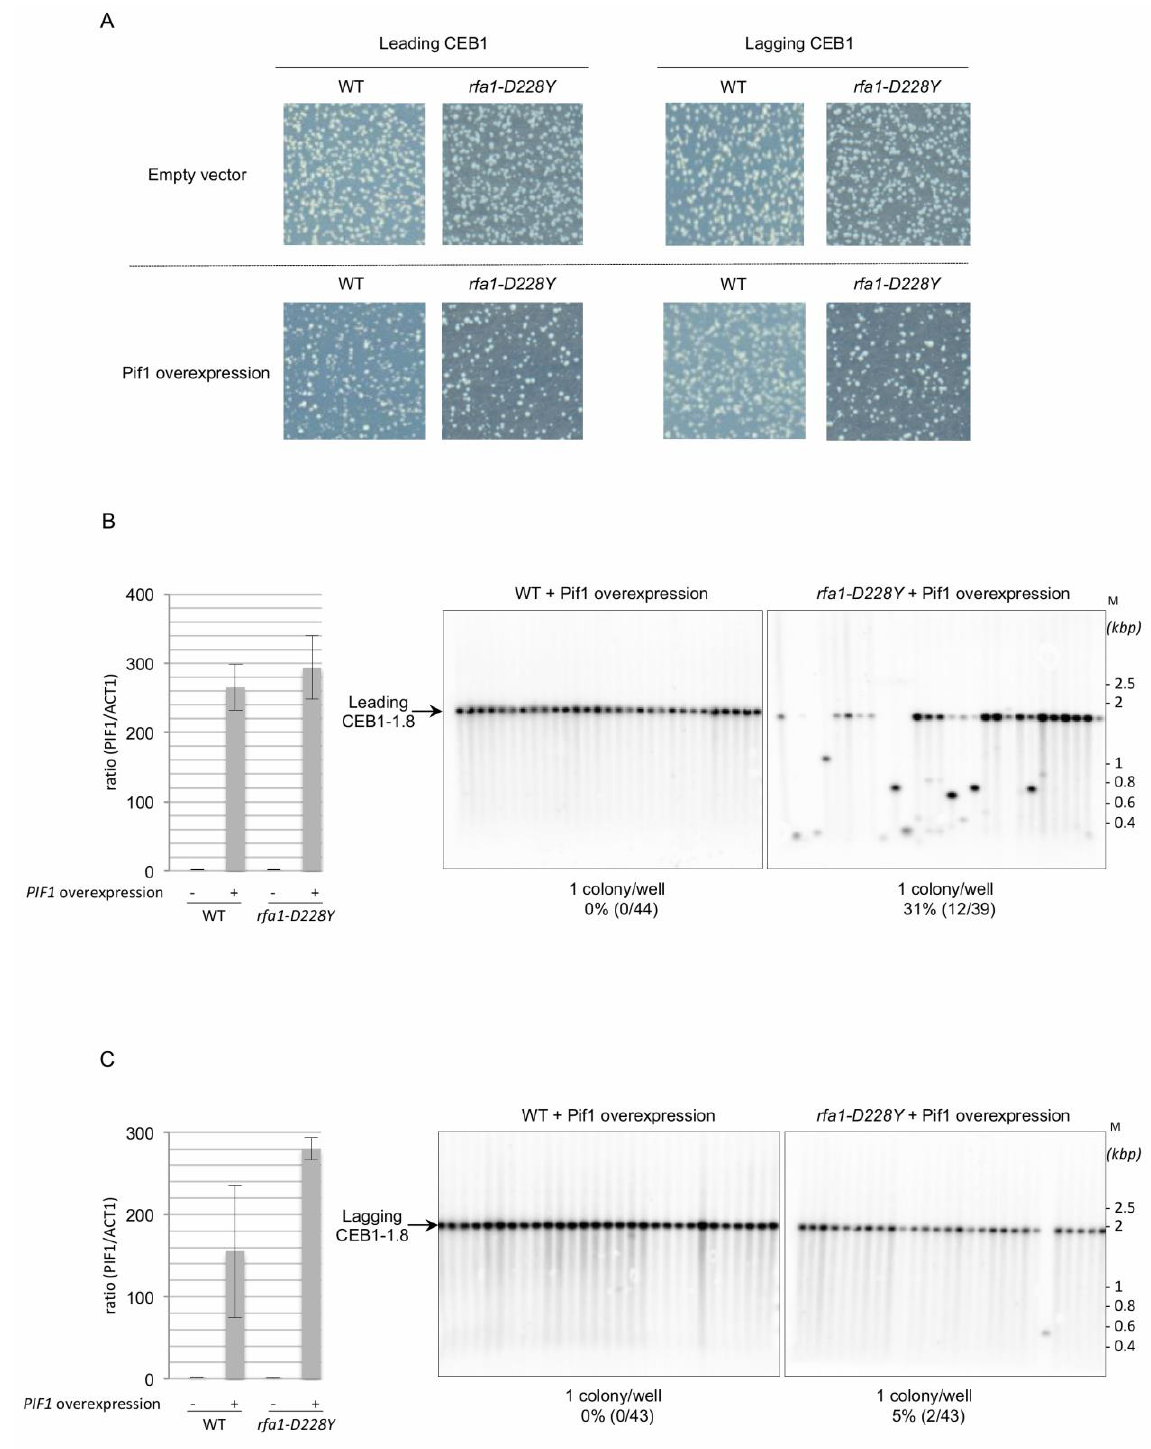
FIGURE 3: Pif1 overexpression rescues lagging-CEB1 instability in the rfa1-D228Y mutant. (A) Colonies containing the leading- or lagging-CEB1, and overexpressing Pif1 (Pif1 overexpression) or not (Empty vector) were plated on galactose medium and subsequently incubated at 30°C. (B) Left: cDNA was prepared from the indicated strains. The ration of PIF1 transcript to that of ACT1 was determined using qPCR. (-): Empty vector, (+): Pif1 overexpres- sion. Right, genomic DNAs from wild-type (WT) or rfa1-D228Y cells overexpressing Pif1 (Pif1 overexpression) and containing the leading-CEB1 were treated as in Figure 2. M: ladder DNA. (C) Left: cDNA was prepared from the indicated strains. The ration of PIF1 transcript to that of ACT1 was deter- mined using qPCR. (-): Empty vector, (+): Pif1 overexpression. Right, genomic DNAs from wild-type (WT) or rfa1-D228Y cells overexpressing Pif1 (Pif1 overexpression) and containing the lagging-CEB1 were treated as in Figure 2. M: ladder DNA. Yeast strains were grown in medium containing galactose (2%). The number of colonies analysed per well, the percentage of rearrangement frequencies, and the total numbers of colonies are indicated in